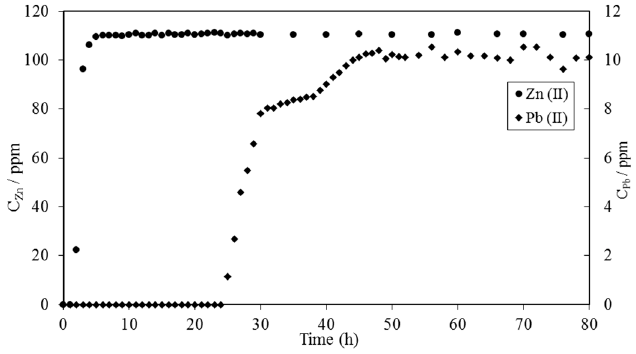
Figure 3. Pb(II) and Zn(II) breakthrough profiles when a solution containing 11 mg/L Pb(II) and 110 mg/L Zn(II) was passed through a column packed with crosslinked lignocatechol. pH = 2.5, weight of adsorbent packed into the column = 0.40 g, flow rate = 3.00 mL/h [6]. (With permission for reuse from Elsevier B.V.).